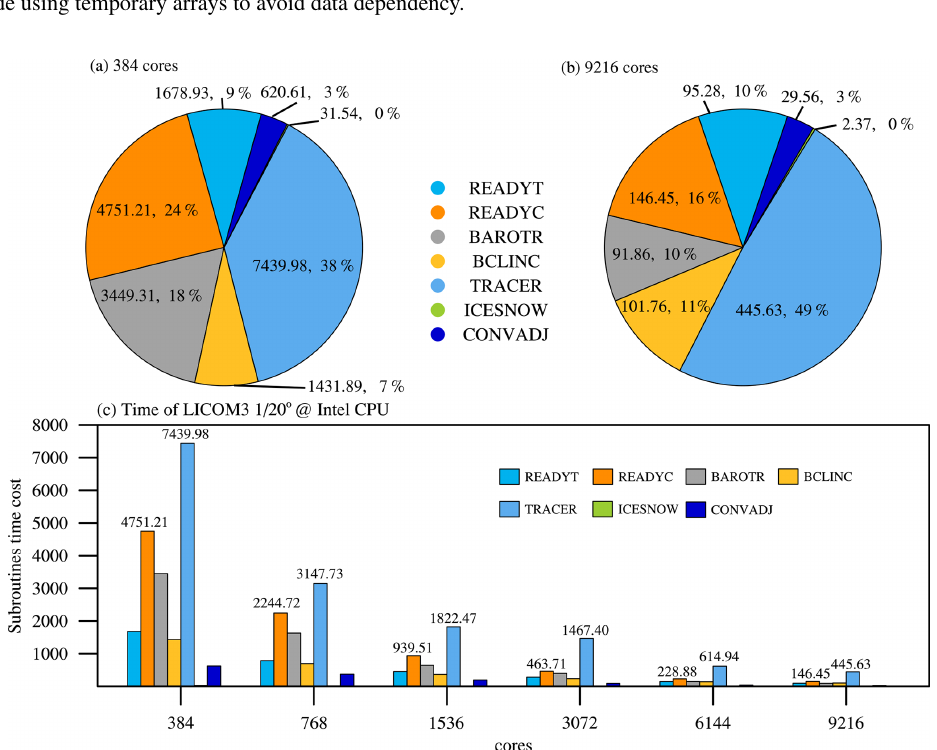
Figure 5. The seven core subroutines’ time cost percentages for (a) 384 and (b) 9216CPU cores. (c) The subroutines’ time cost at different scales of LICOM3 (1 / 20 ◦ ). These tests were conducted on an Intel Xeon CPU platform (E5-2697A v4, 2.60GHz).